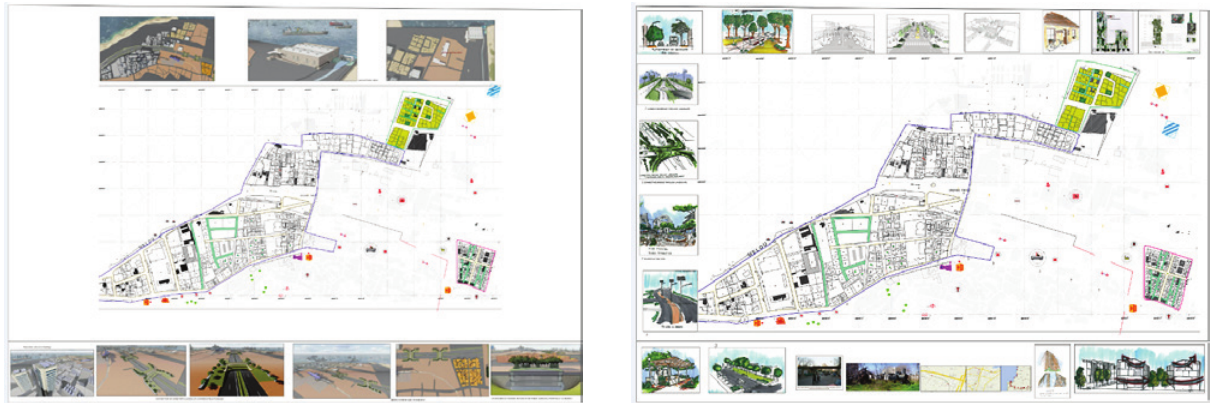
Figure 8. Final proposal for sustainable